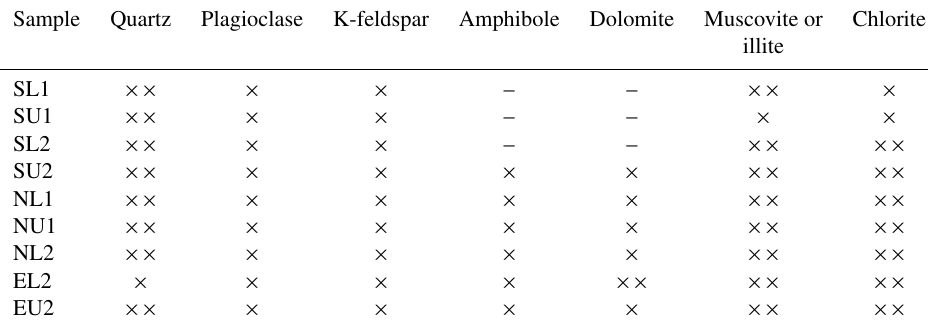
Table A1. Mineral composition in particular samples analysed by X-ray diffraction. The × symbol means presence of the mineral; ×× means high presence of the mineral. The sign “–” means that the mineral was not detected. Abbreviations of samples refer to the glacier where the cryoconite was sampled, the part of the ablation zone and the number of the sampling